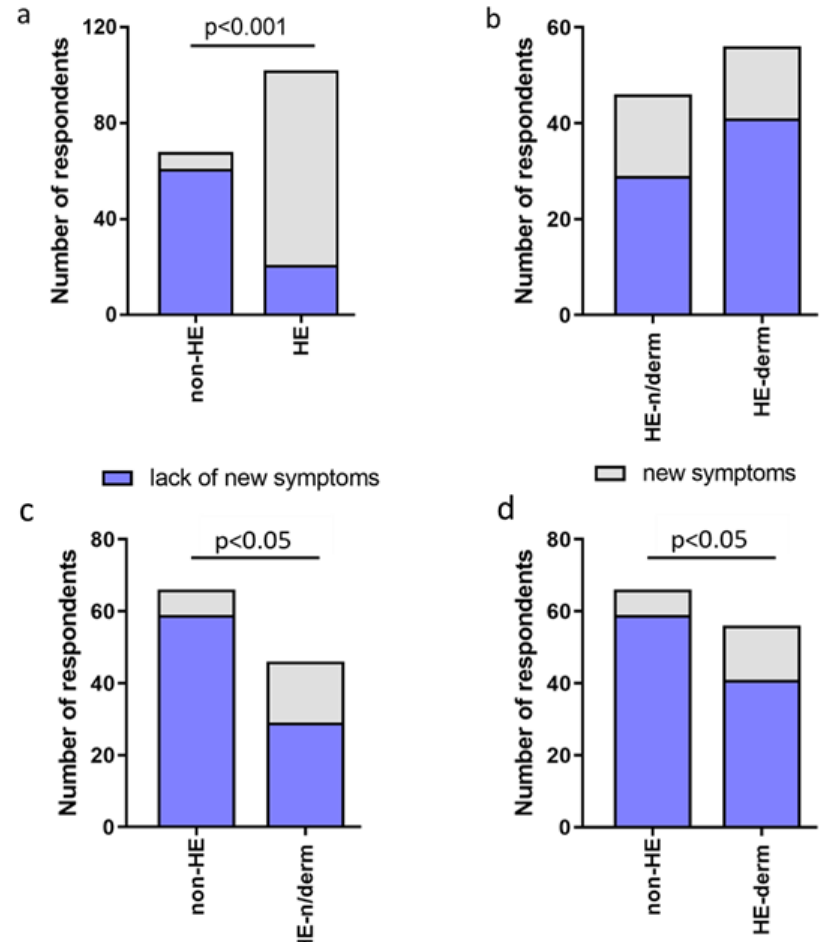
Figure 3. Comparison of occurrence of new symptoms in study groups: ( a ) non-HE vs. HE; ( b ) HE- n/derm vs. HE-derm; ( c ) non-HE vs. HE-n/derm; ( d ) non-HE vs. HE-derm. 83/102 (81.37%) respondents from the HE-study group and 27/68 (39.71%) out of non- HE group immediately after the application of an alcohol-based disinfectant experienced more than one symptom, most often it was dryness (HE-study group: 87/102 (85.29%); non-HE group: 37/68 (54.41%)), roughness (HE-study group: 59/102 (57.84%); non-HE group: 22/68 (32.35%)), and redness (HE-study group: 53/102 (51.96%); non-HE group: 15/68 (22.06%)) (Figure 4).